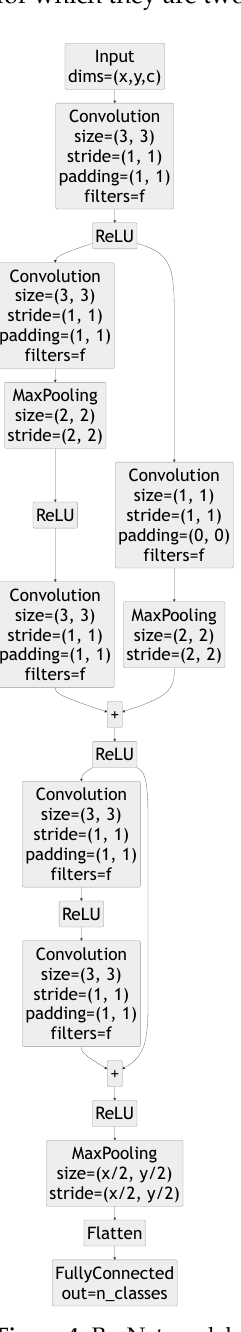
Figure 4. ResNet model